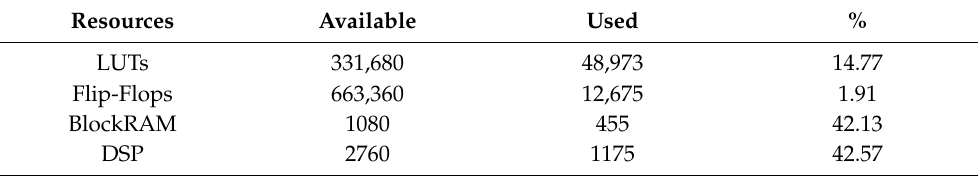
Table 6. Kintex Ultrascale XQRKU060 Resource occupation for the hardware